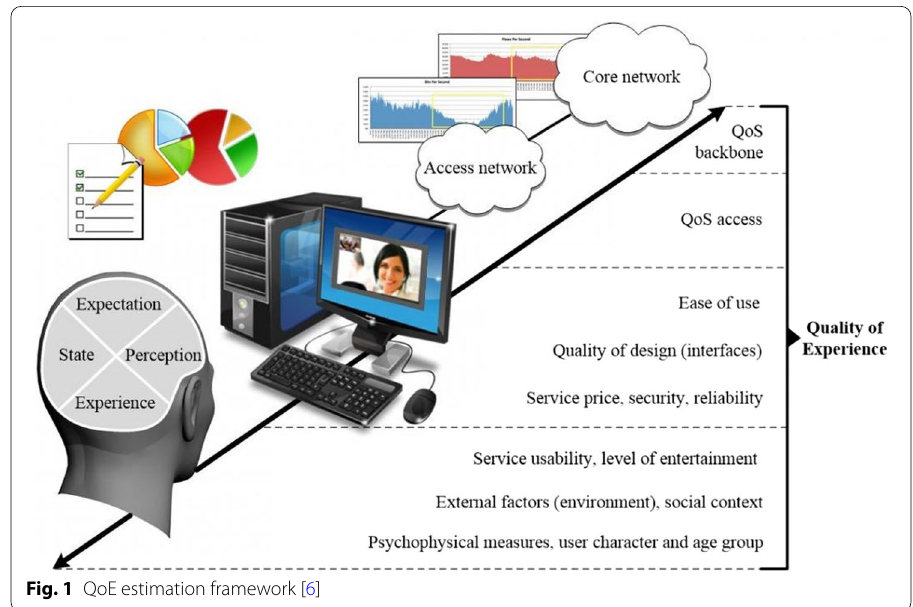
Fig. 1 QoE estimation framework